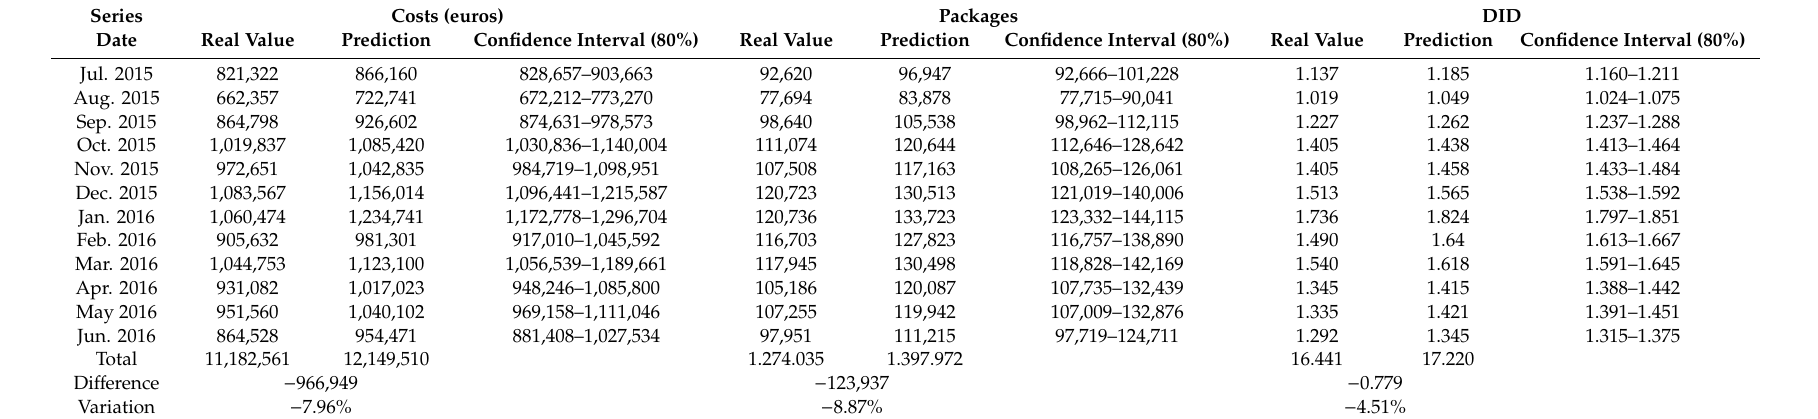
Table A4. Savings from PRAN approval (predictions with the ARIMA models in Table